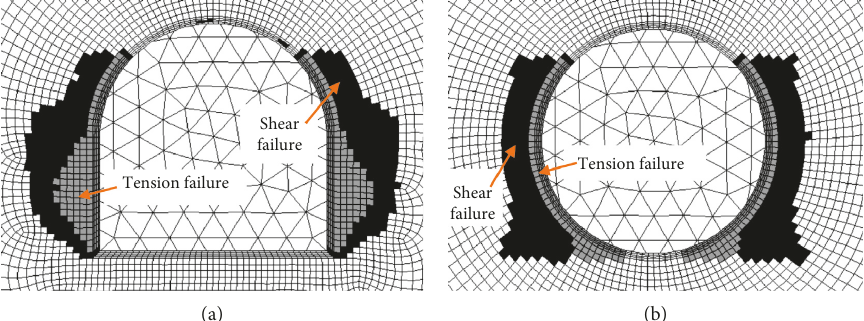
Figure 18: The distribution of the plastic zone in the surrounding rock after excavation. (a) The horseshoe tunnel. (b) The circular